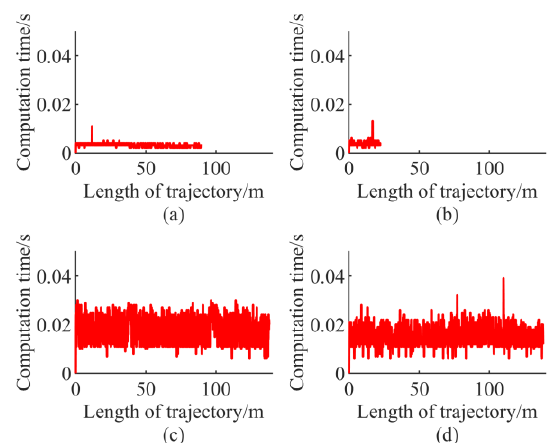
Figure 37. The heading error with the positioning error in ±0.2m. ( a ) LMPC. ( b ) LEMPC. ( c ) NMPC. ( d ) NEMPC.